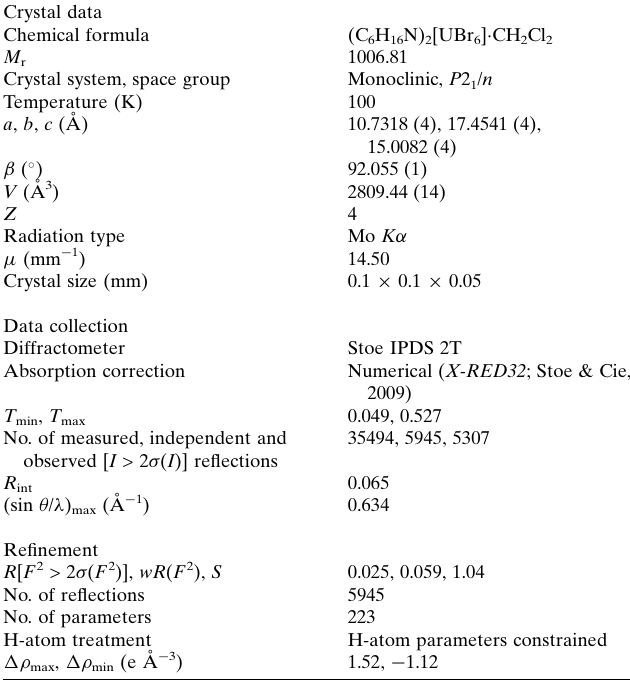
Table 3 Experimental details. Crystal data Chemical